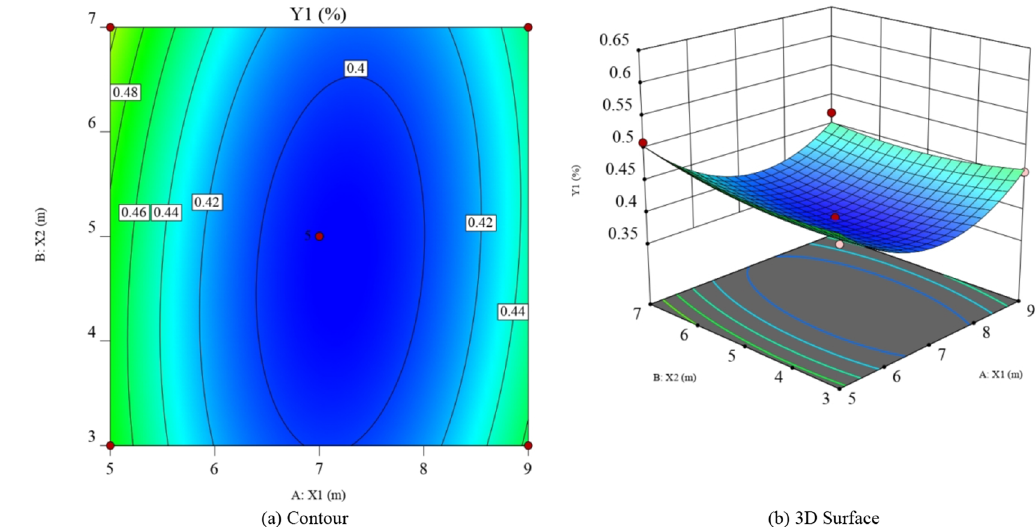
Figure 10. Response graph of the influence of various factors on the gas concentration in upper corner (Design-Expert 10).